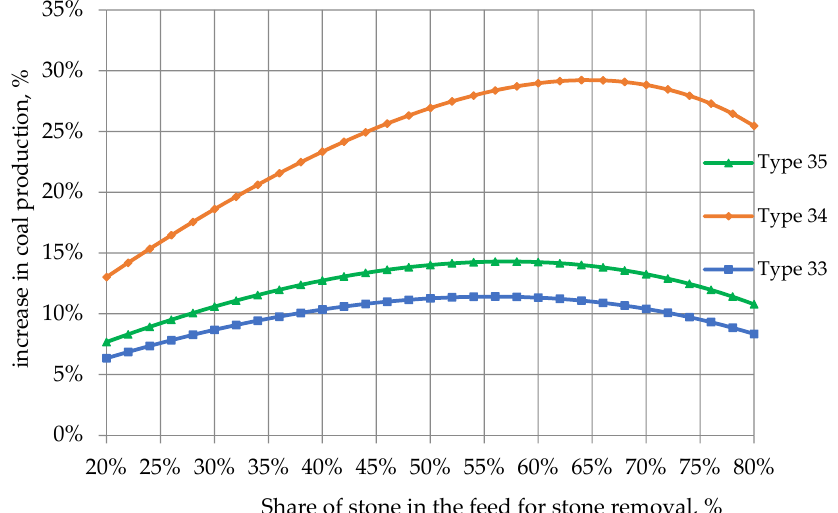
Figure 9. The economic effect of selective crushing for different compositions configurations of the run-of-mine.